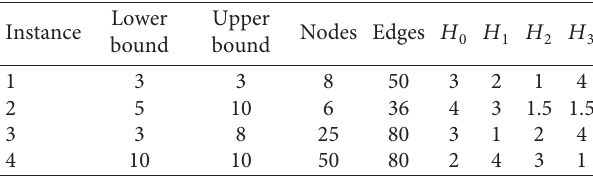
Table 4: Characteristics for